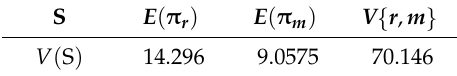
Table 3. Income under different markets.